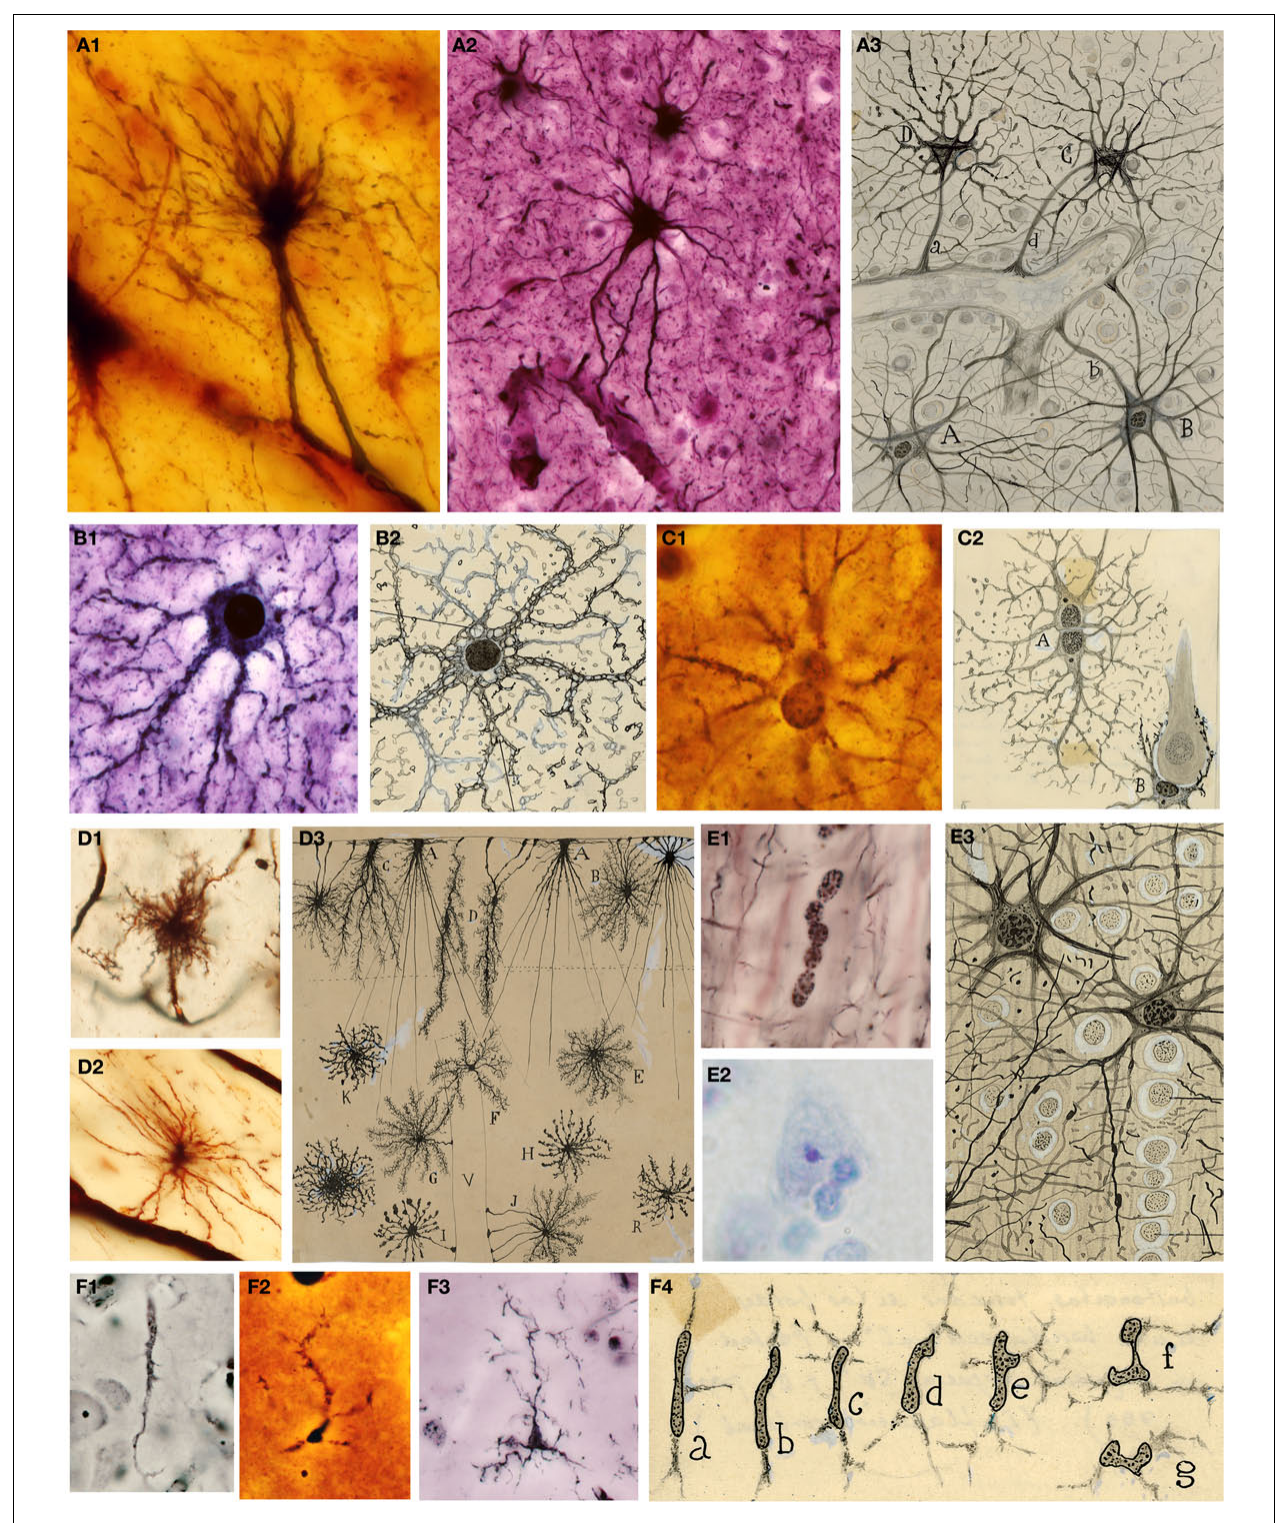
FIGURE 7 | Cajal’s histological preparations and drawings showing some contributions to glial cells. (A) Fibrous astrocyte in the white matter of adult brain (formalin-uranium nitrate and gold-sublimated chloride); (B) Protoplasmic astrocyte in an adult brain (silver carbonate (del Rio) and formalin-uranium nitrate); (C) Twin astrocytes in the human hippocampus (formalin-uranium